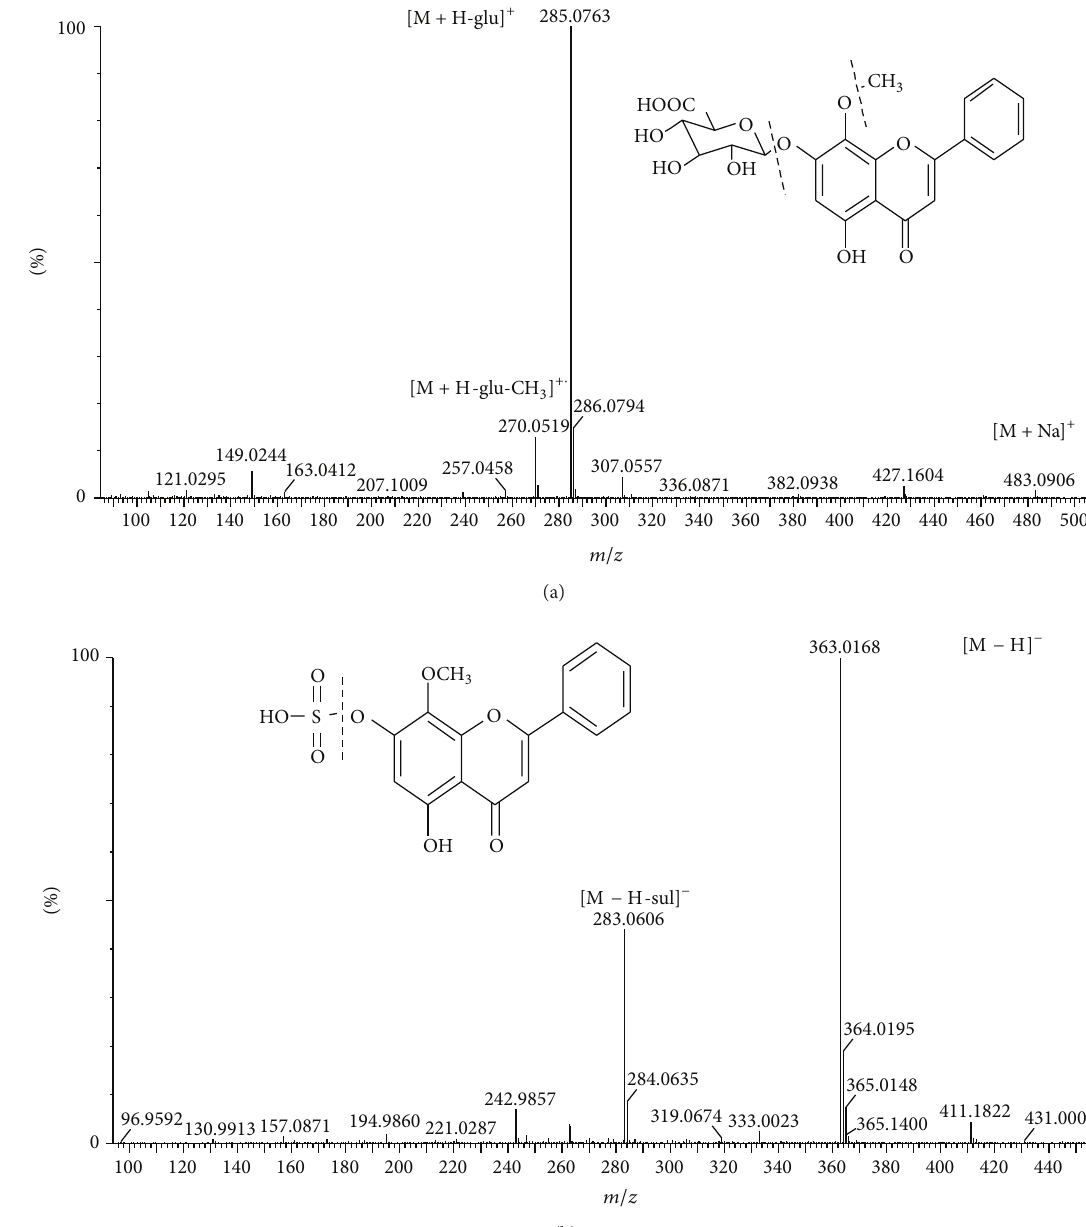
Figure 6: MS/MS spectra and structures of (a) prototype compound wogonoside in positive ion mode and (b) flavonoids metabolite wogonin 7-sulfate in negative ion mode identified in human serum after SHLI administration. In the tag, glu was the abbreviation of glucuronide-H 2 O and sul was the abbreviation of sulfate-H 2